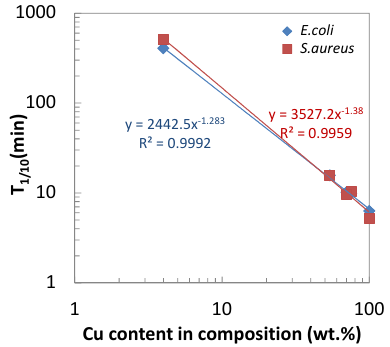
Figure 7. Correlation of the time to reduce the number of viable cells 1/10 of the initial number of cells (T 1/10 ) for testing materials against E. coli and S.aureus . The classification of 3 groups (A–C) is identified as circled.